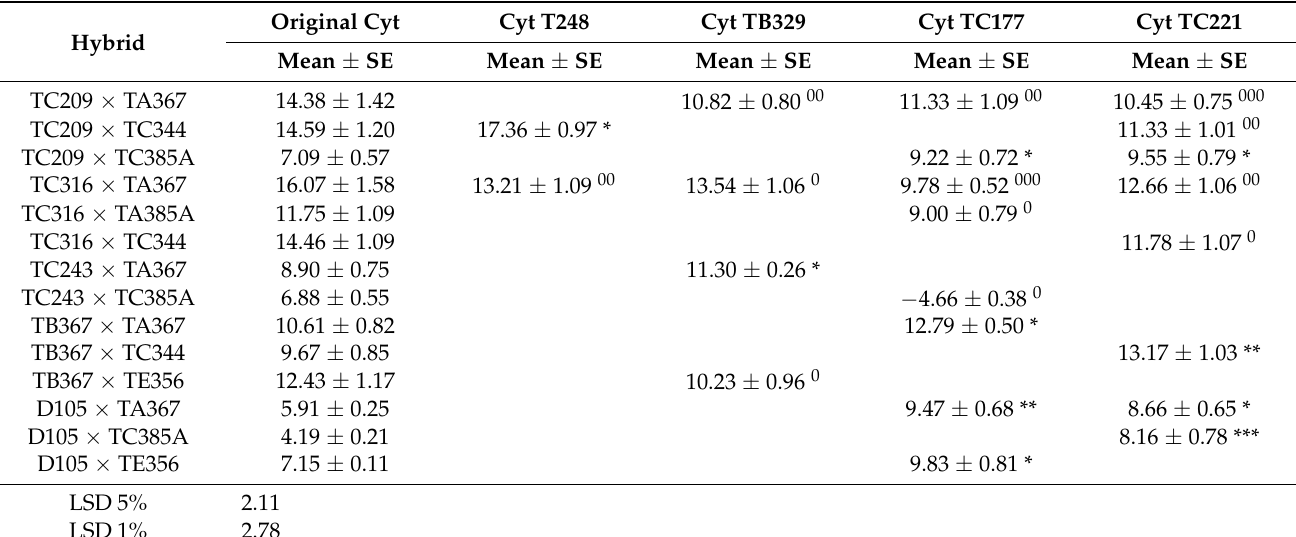
Table 6. The influence of cytoplasm × nucleus × tester interaction on some hybrids’ content in total carotenoids ( µ g/g)—ANOVA